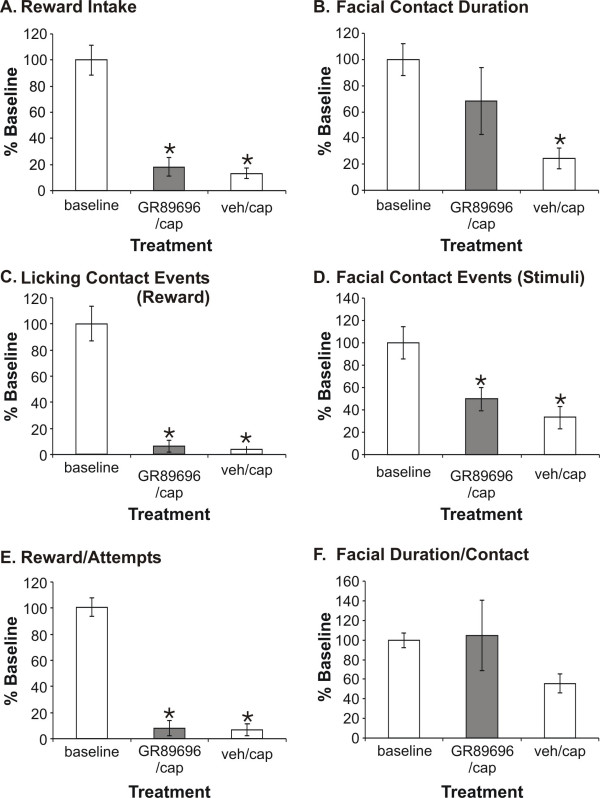
We found that GR89,696 does not affect operant thermal outcome measures. Animals treated with either GR89,696 (1.25 × 10-4 mg/kg, subcutaneous) or vehicle (PBS, subcutaneous) prior to facial capsaicin application did not significantly differ from each other when evaluated using the six thermal operant outcome measures (N = 10). Both groups were significantly lower (*P < 0.05) than baseline values in all instances except for GR89696 in Facial Contact Duration (B) and for both GR89696 and vehicle for Facial Duration/Contact (F). Overall, this indicates that the neurogenic inflammatory pain was not inhibited following capsaicin application.